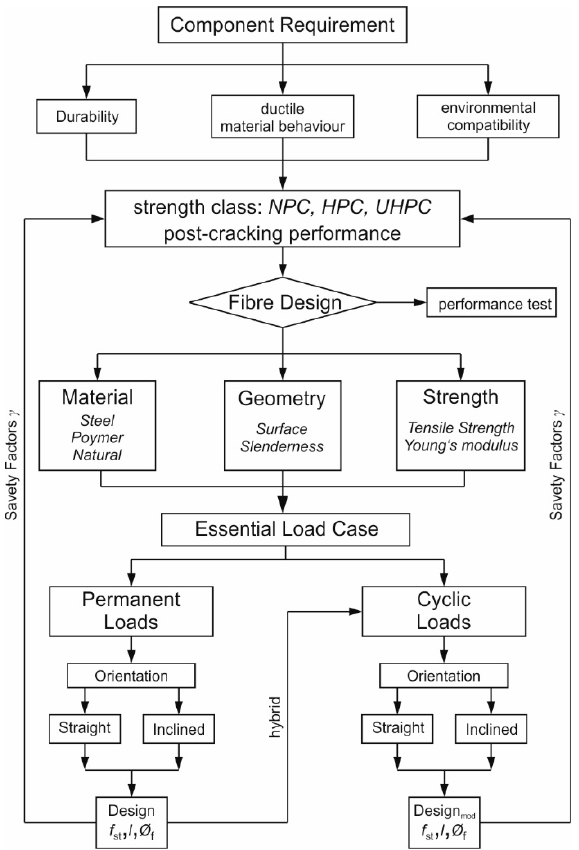
Figure 2. Flow chart for a deterministic fibre design.